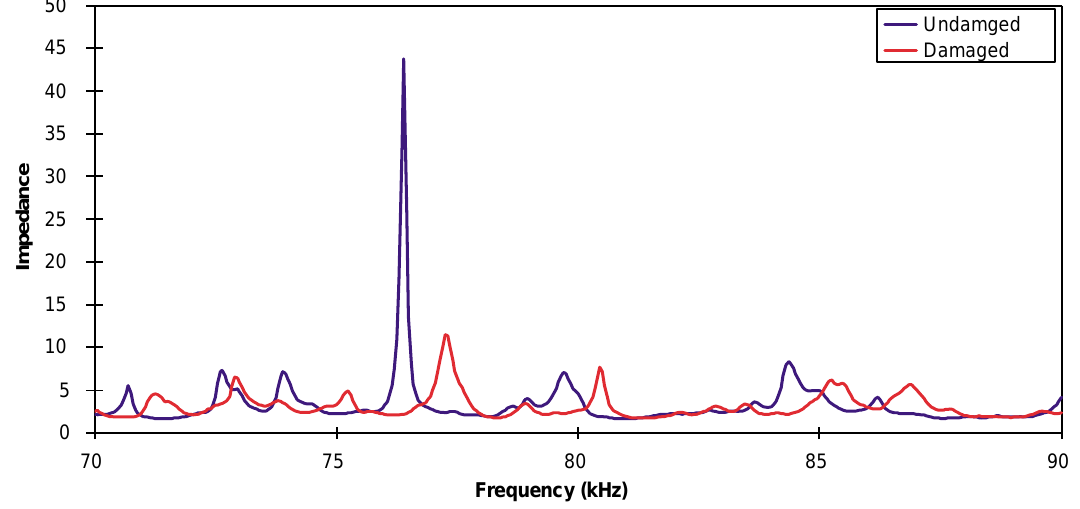
Fig. 2. Impedance measurement (real part) of PZT 3 for both undamaged and damaged